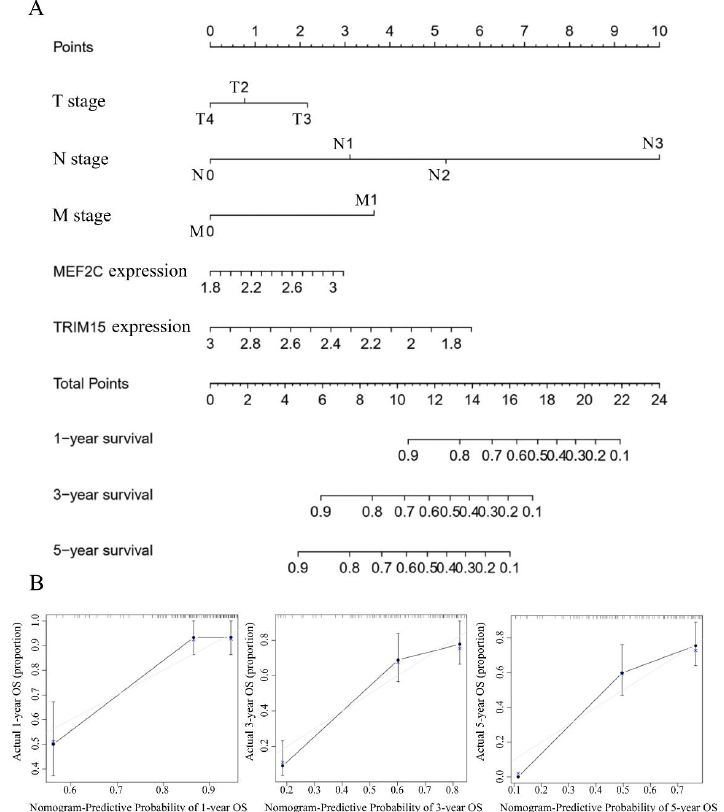
Figure 4. Construction and internal validation of nomogram. ( A ) The predictive nomogram was established with T-stage, N-stage, M-stage and expression level of MEF2C and TRIM15 in diffuse-type gastric cancer. ( B ) A comparison of predictive and actual outcome for 1-, 3- and 5-year survival probabilities in the nomogram is demonstrated in calibration curves for internal validation. 3.6. Evaluation the Predictive Performance of Nomogram and External Validation of Nomogram The AUC of the predicted 1-, 3- and 5-year overall survival were 0.82, 0.84 and 0.87, respectively (Figure 5A). When the seventh AJCC TNM stage was used, the AUC values